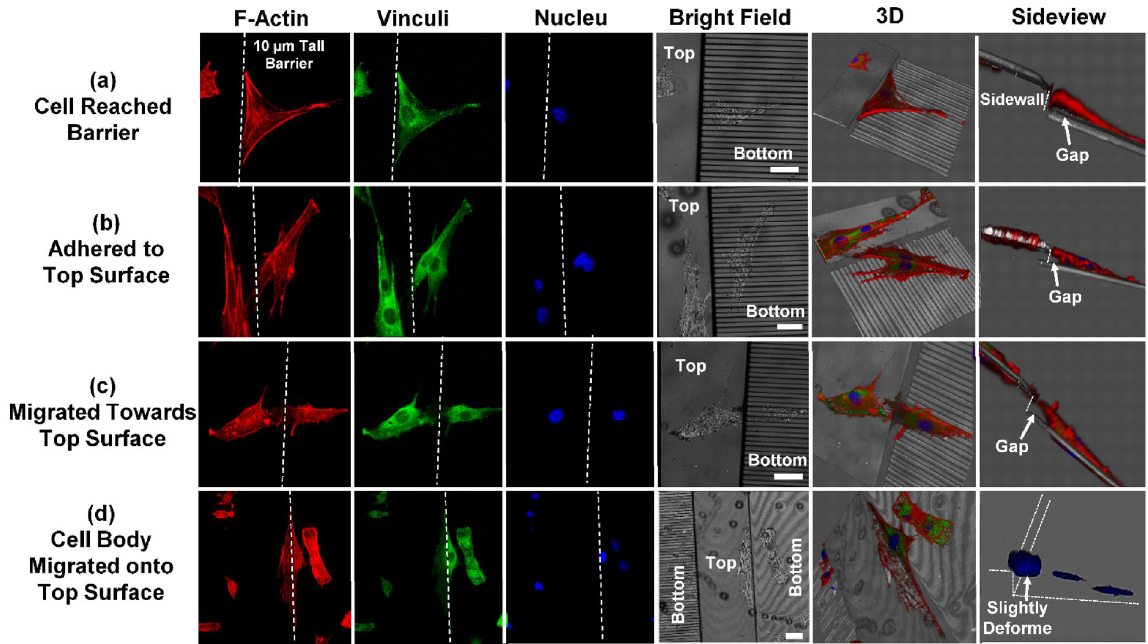
Figure 7. Immunofluorescence micrographs showing MC3T3 cells climbing up 10 µm tall barriers. Red: F-actin; green: vinculin; blue: nucleus; grey: reflected bright field. ( a ) MC3T3 cell on bottom surface reached barrier. ( b ) Cell adhered to top surface and formed elevated morphology. ( c ) Cell aligned and moved towards top surface. ( d ) Cell body and nucleus moved onto top surface. Slight nucleus deformation was observed at barrier edge. All scale bars in the micrographs are 20 µm.